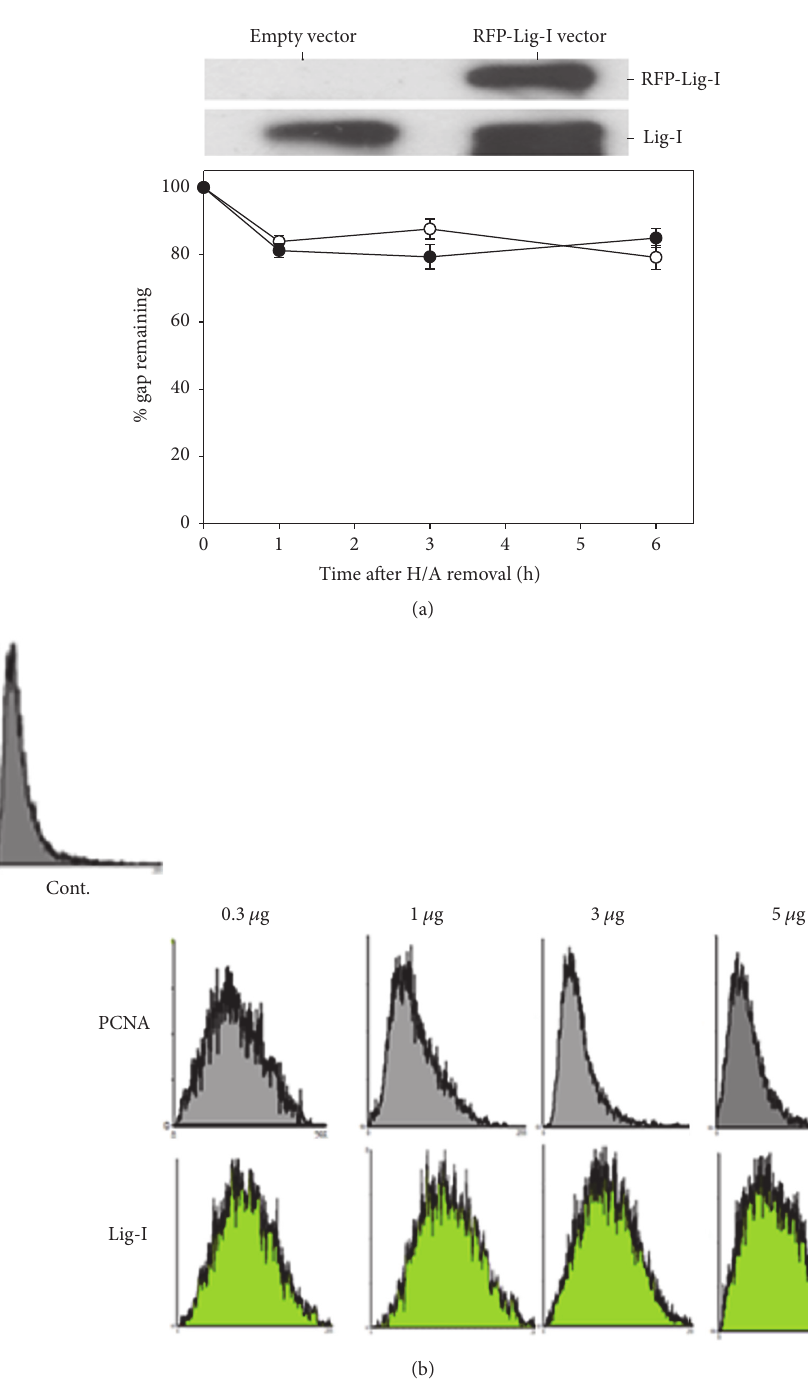
Figure 5: The effect of Lig-1 overexpression on colcemid-caused delay of gap-filling during repair of UV-induced DNA lesions. (a) Top: western analysis of Lig-1 protein in CL1-0 cells stably transfected with expression plasmid of Lig-1 (RFP-Lig-1) or empty vector. Bottom: similar to Figure 1, yet the CL1-0 cells stably transfected with expression plasmid of Lig-1 (filled circle) or empty vector (open circle) were used. (b) Flow cytometric analysis of nucleoid size. Dose dependence. Cells were transiently transfected with various amounts of PCNA or ligase-I expression